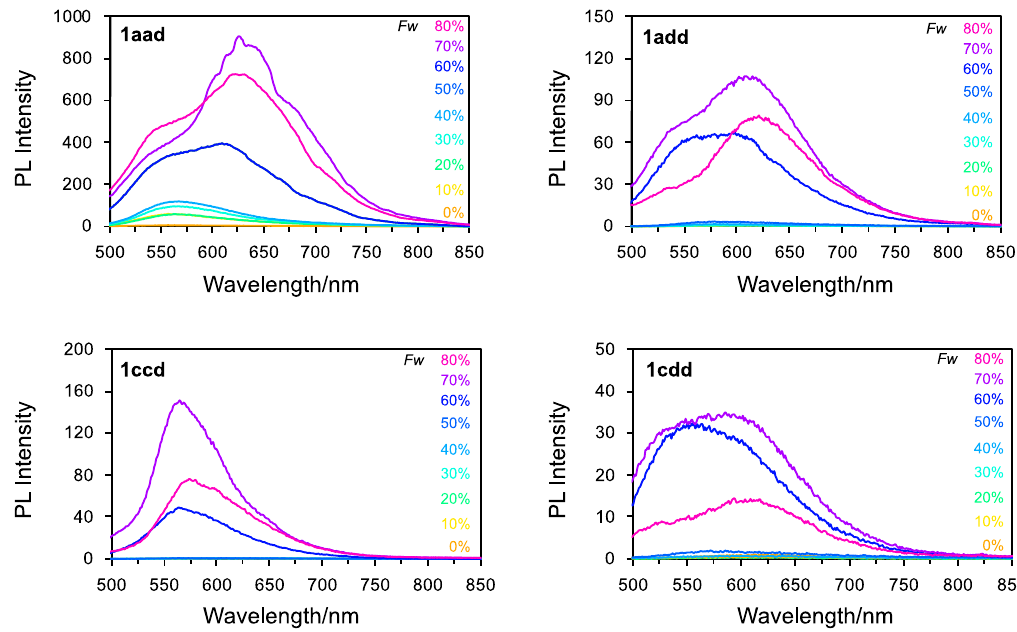
Figure 8. Fluorescence spectra of 1aad , 1add , 1ccd , and 1cdd recorded in various THF/H 2 O mixtures.